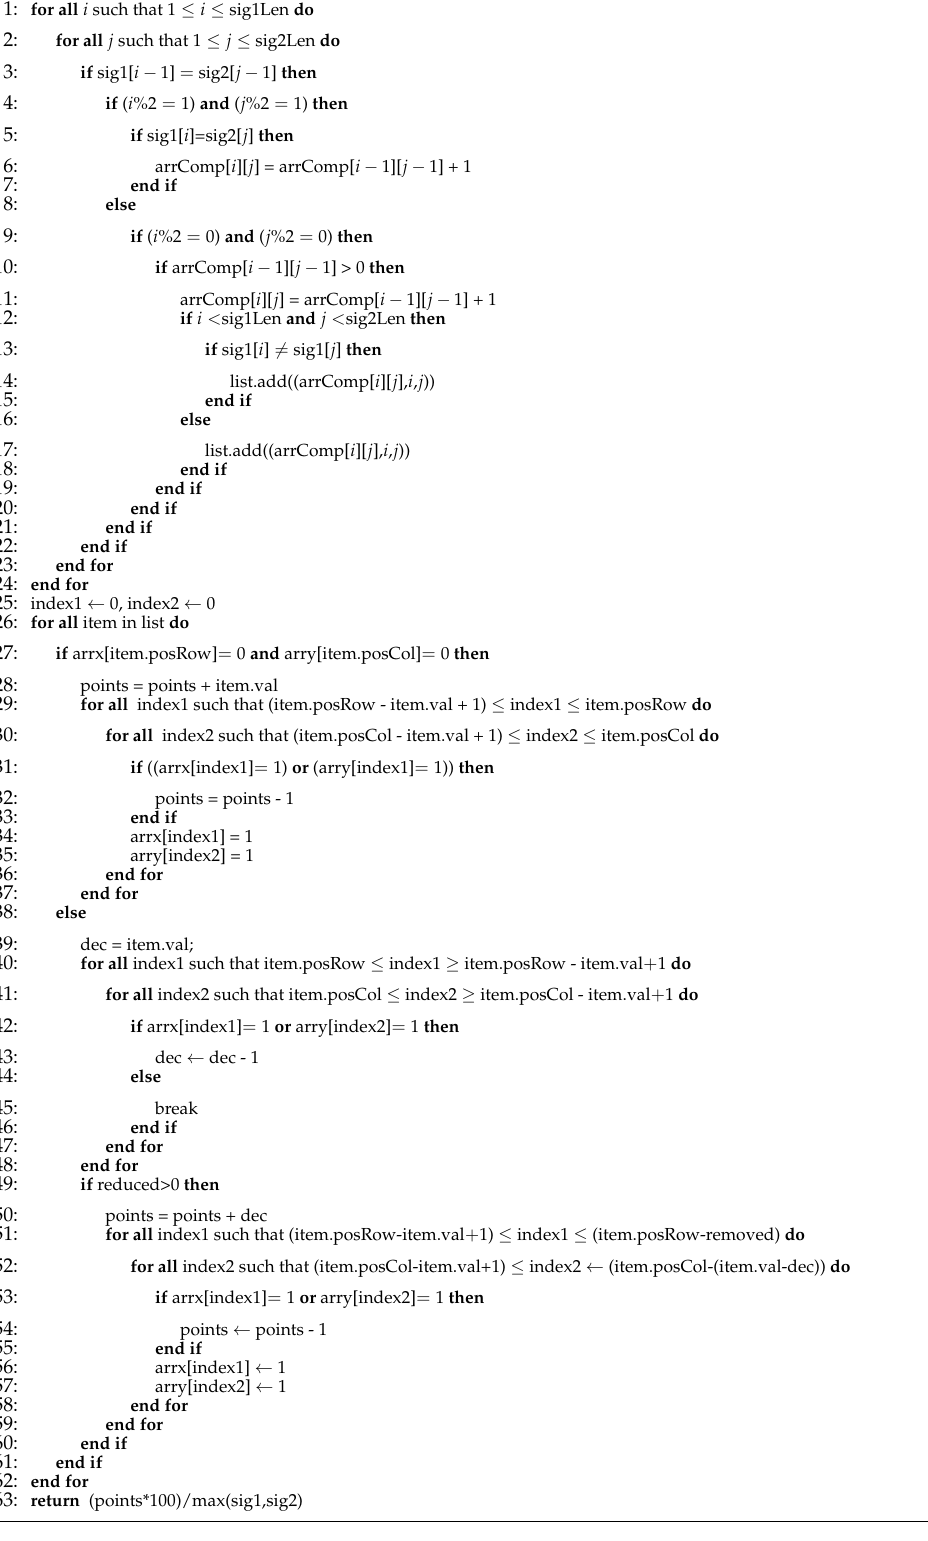
Algorithm 2 SiSe signature